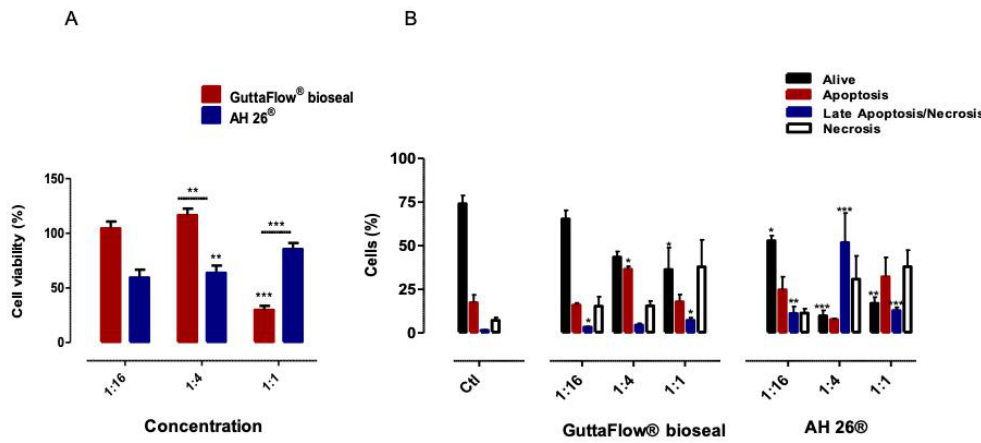
Figure 2. Cell viability ( A ) and types of cell death ( B ) of the MDPC-23 cell cultures after 24 h of incubation with the biomaterials conditioned media. The results are presented as the mean and standard error, with a minimum of six independent assays. Statistically significant differences to the control or between conditions are represented by a *, where * means p < 0.05, ** means p < 0.01, and *** means p < 0.001.